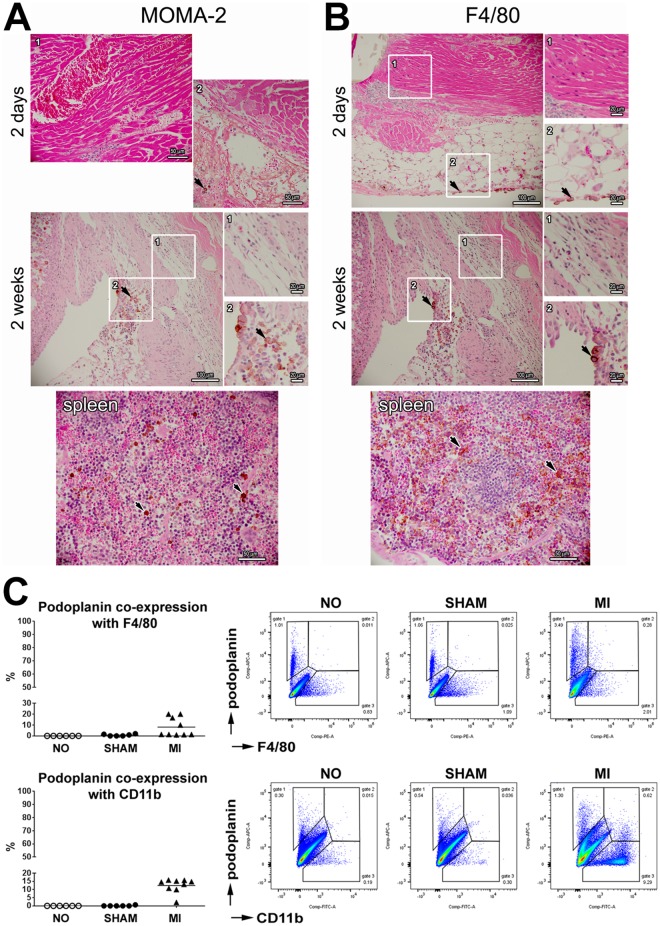
Low expression of monocyte-macrophage markers in the populations of podoplanin-positive cells in the infarcted myocardium.(A,B) Thin cardiac sections were indirectly immunolabeled with MOMA-2 (A) or F4/80 (B) antibodies and counterstained with hematoxylin and eosin. Time after MI is indicated. Spleen sections were included as positive controls. Areas in rectangles with the corresponding numbers are shown at a higher magnification in the adjacent insets. Note the presence of cells immunoreactive for MOMA-2 or F4/80 (arrows) in the inflamed epicardium (2 days, insets 2), myocardial interstitium (2 weeks, insets 2) and spleen, but not in the BZ of necrotic myocardium (2 days, insets 1) or the maturing scar (2 weeks, insets 1). (C) Flow-cytometry analysis of the F4/80 or CD11b expression in the podoplanin-positive cohorts populating the hearts of non-infarcted (NO), sham-operated (SHAM) and infarcted (MI) mice at 2 days after surgery. Graphs displaying individual values and the respective means (left), as well as representative scatterplots (right) are shown. Data represent frequency of double-positive cells within podoplanin-labeled populations (calculated as % cells in gate 2 out of the sum of cells in gate 1 and gate 2).